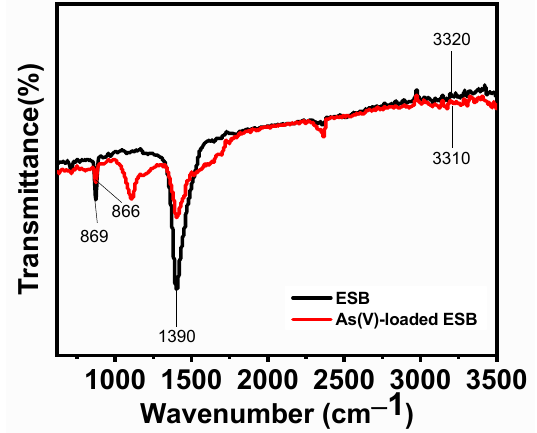
Figure 4. FTIR spectra of egg shell biochar (ESB).